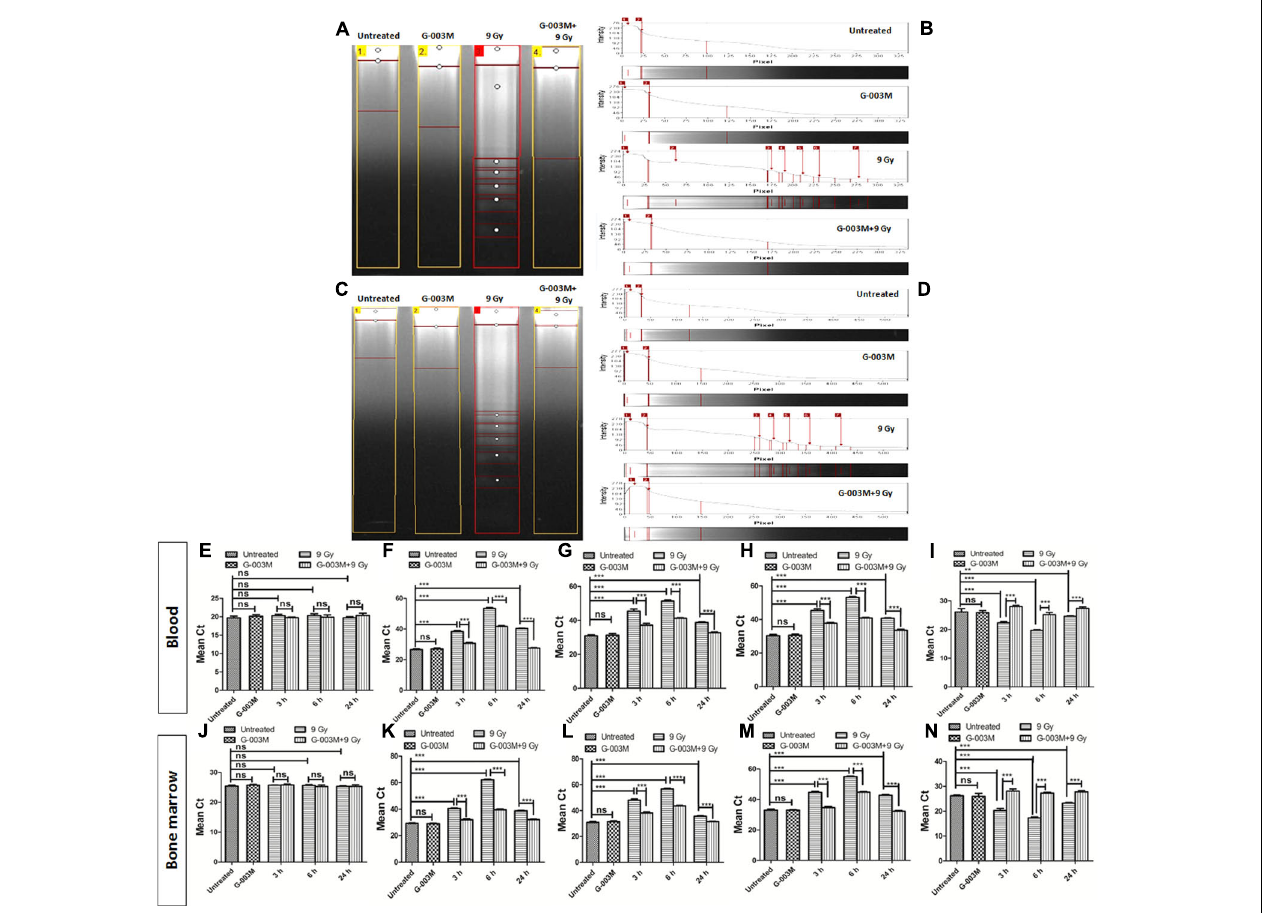
FIGURE 7 | Apoptosis measurement after 9 Gy exposure and its modulation by the combination G-003M: (A) DNA fragmentation of different treatment groups at 6 h time points in blood cells. (B) The histogram represents the individual lanes with the band intensity of fragmented genomic DNA from blood cells. (C) DNA fragmentation of different treatment groups at 6 h time points in bone marrow cells (D) The histogram represents the individual lanes with the band intensity of fragmented genomic DNA from bone-marrow cells. (E–I) represent quantitative real time PCR analysis of β -actin, p53, Caspase 3, BAX and BCL 2 along at 3, 6, and 24 h time points in blood cells respectively. (J–N) represent quantitative real time PCR analysis of p53, Caspase 3, BAX and BCL 2 at 3, 6, and 24 h time points bone marrow cells. n = 6 per